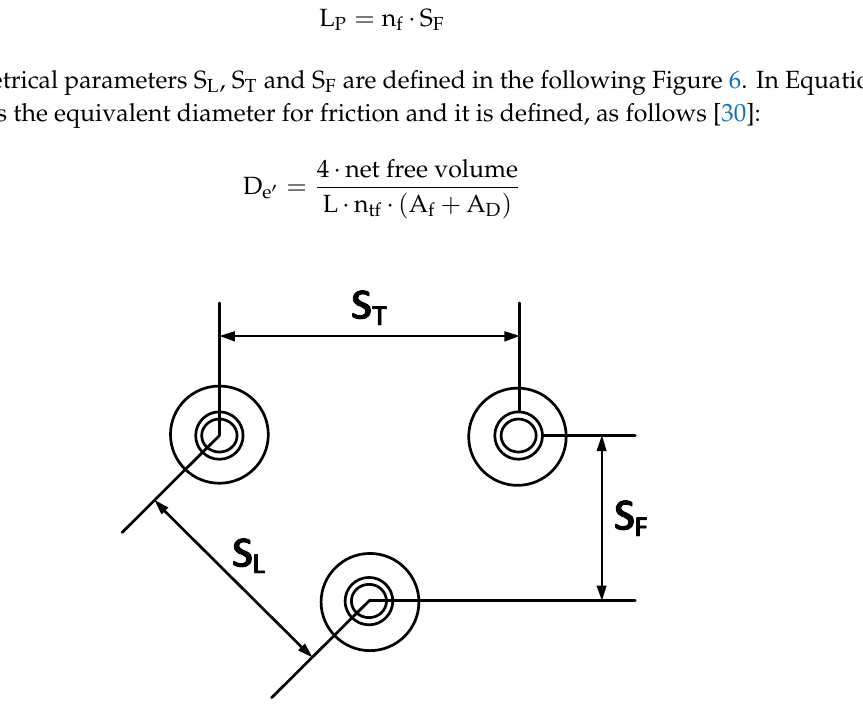
Figure 6. Graphical representation of the geometrical dimensions S T , S L , and S F of the heat exchanger tubes [30].